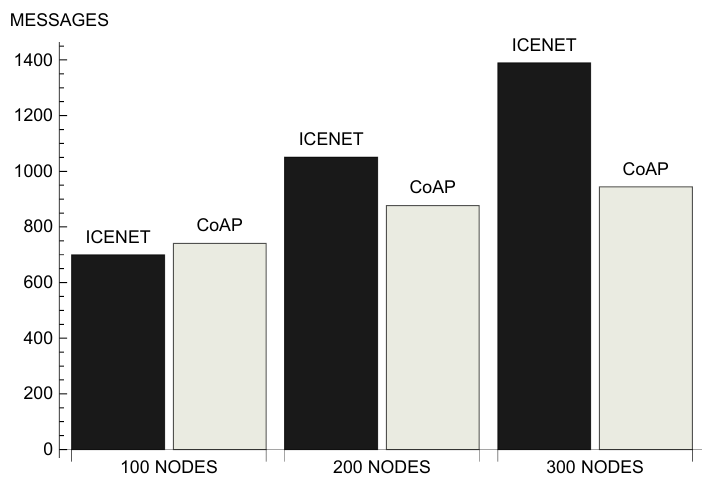
Figure 10. Number of data messages received by gateway.